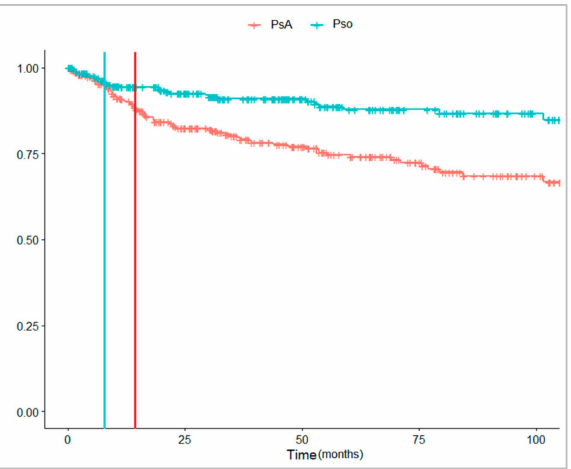
Figure 5. Time (months) from the first csDMARD dispensing to the first bDMARD dispensing in the years 2010–2018, stratified by PsA/PsO. Legend: PsA, psoriatic arthritis; PsO,